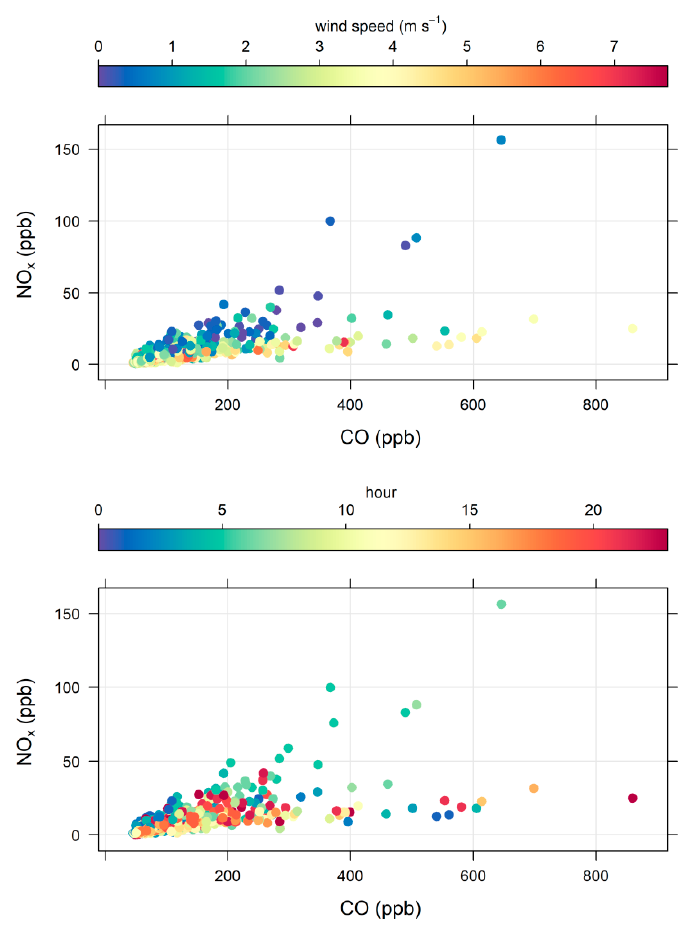
Figure A2. NO x plotted against CO measured at the main MUMBA site. The top plot is coloured by wind direction; the middle plot is coloured by wind speed and the bottom plot is coloured by the hour of the day.